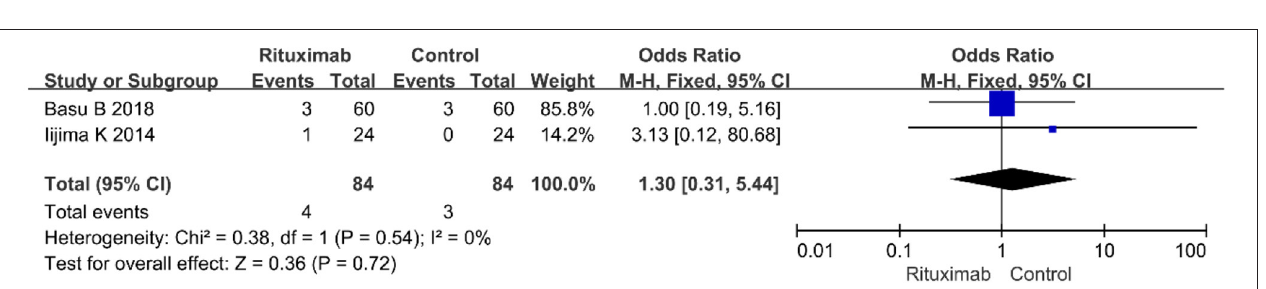
FIGURE 10 | Forest plot showing a meta-analysis of cardiovascular disease events between rituximab treatment group and control